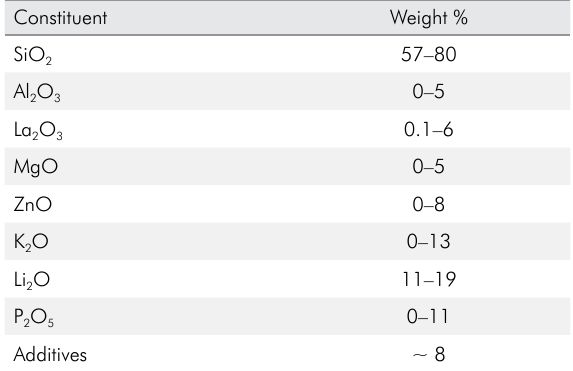
Table 2. Composition of the glass-ceramic lithium